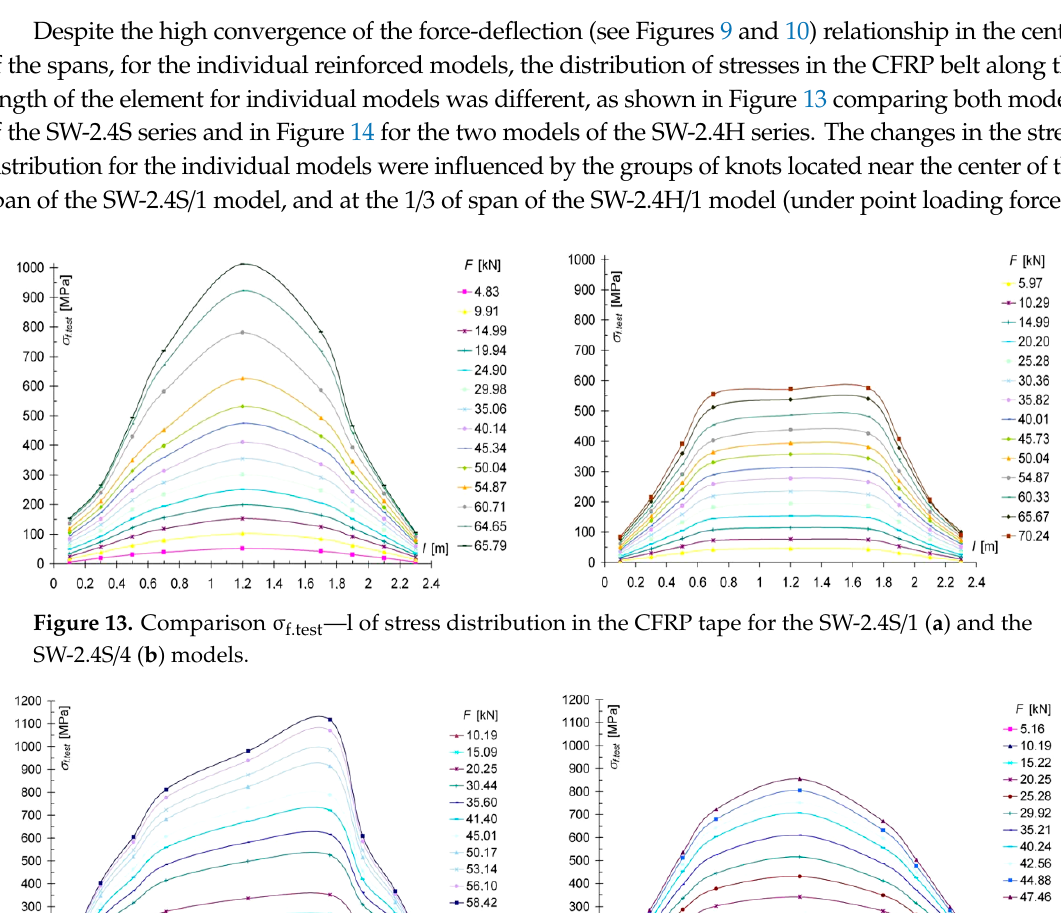
Figure 13. Comparison σ f.test —l of stress distribution in the CFRP tape for the SW-2.4S/1( a ) and the SW-2.4S/4( b ) models. Figure 14. Comparison σ f.test —l of stress distribution in the CFRP tape for the SW-2.4H / 1 ( a ) and the SW-2.4H / 3 ( b ) models.